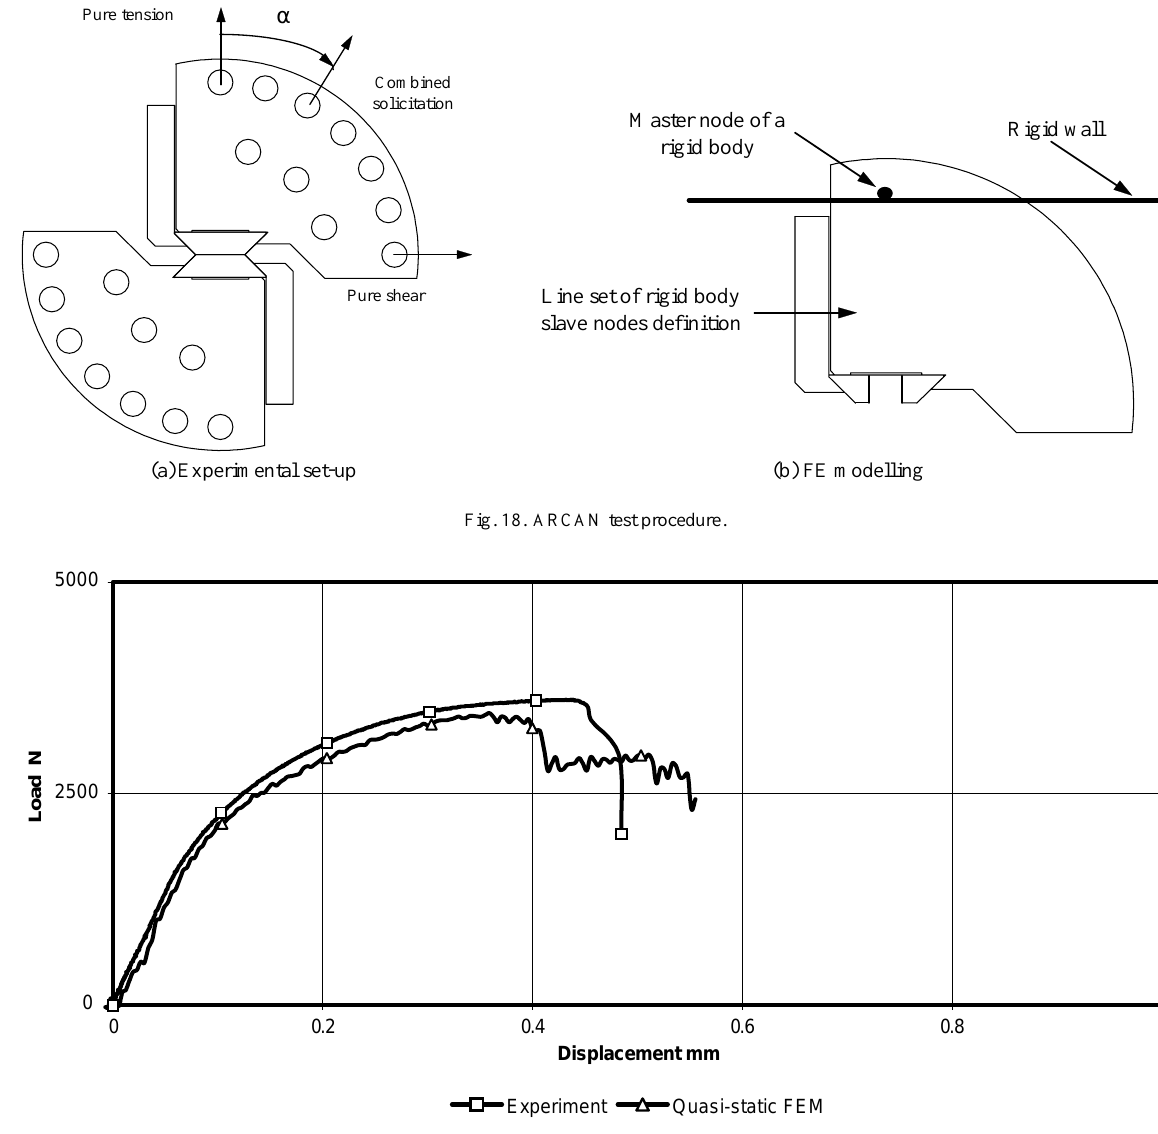
Fig. 19. Load vs. displacement diagram – ARCAN test in pure